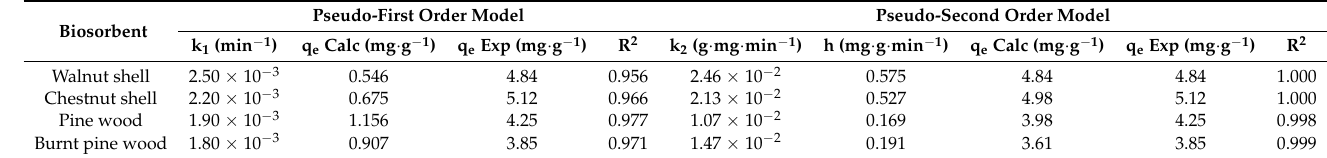
Table 3. Parameters for the kinetic sorption data using pseudo-first order and pseudo-second order kinetic models.